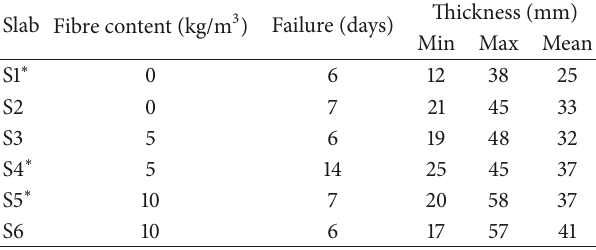
Table 3: Amount of glass fibre reinforcement, time at failure due to shrinkage, and measured thickness for slabs 1–6 tested by Bryne et al. [17]. Slabs S1, S4, and S5 are here analysed using FE modelling. Slab Fibre content (kg/m 3 ) Failure